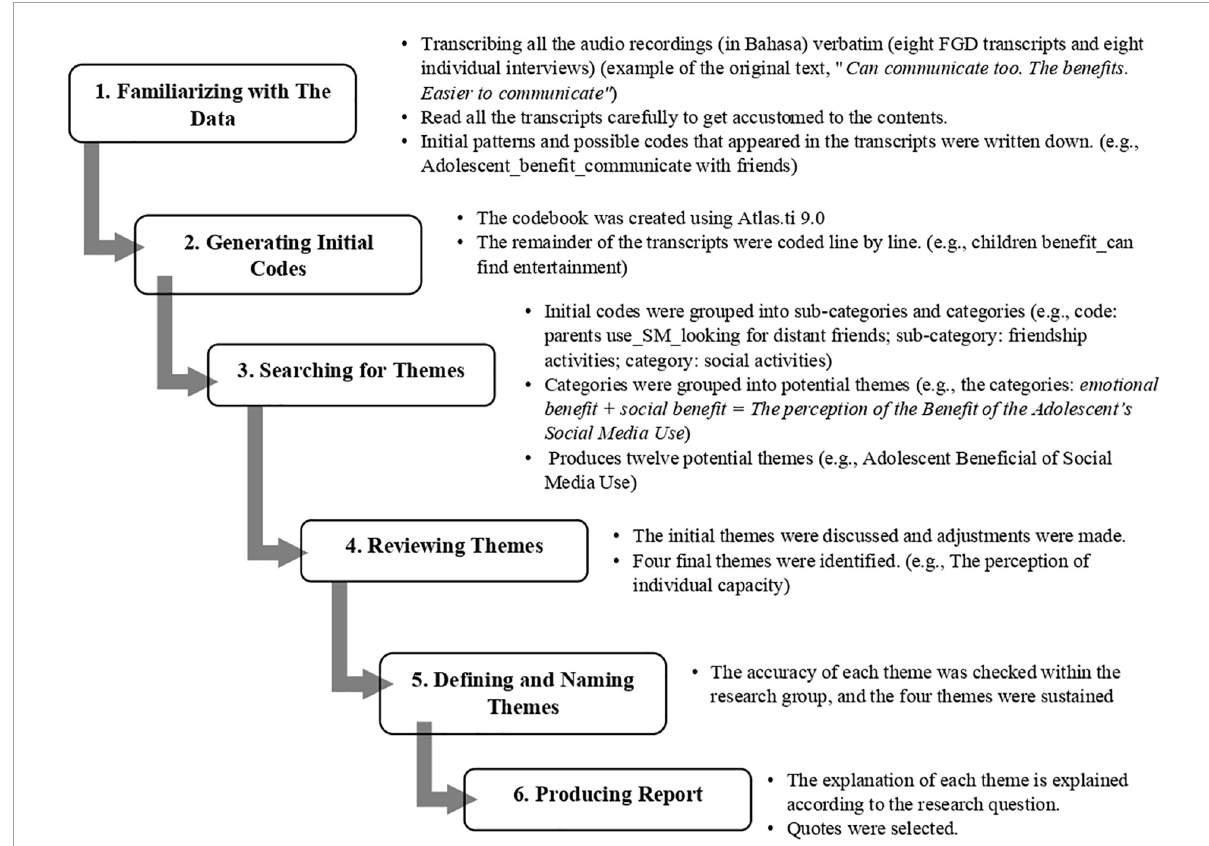
FIGURE2 Six-step of thematic analysis (Braun and Clarke, 2006) (https://www.shutterstock.com/en/image-vector/illustration-vector-map-bandung-